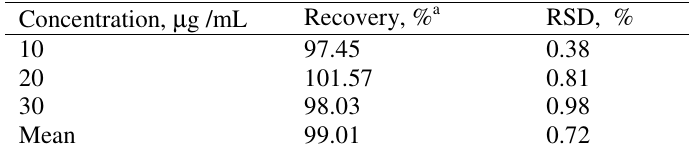
Table 2. Accuracy for